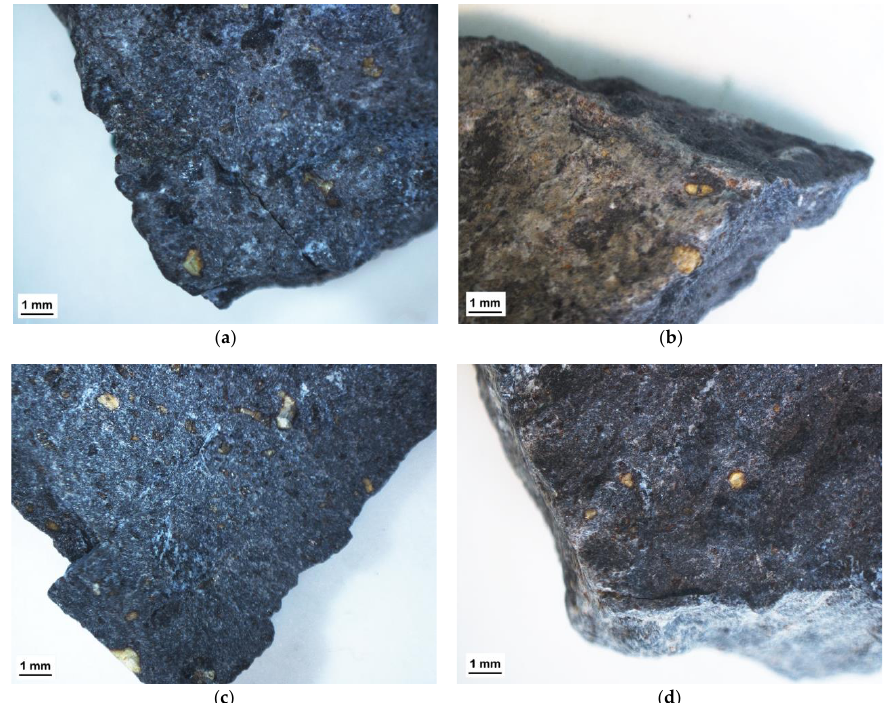
Figure A11. Characteristics of cracks in samples after crushing in cone crusher (feed—non-flaky grains): ( a ) Basalt aggregate 1, non-flaky grains, +8 mm; ( b ) Basalt aggregate 1, non-flaky grains, +16 mm; ( c ) Basalt aggregate 1, flaky grains, +8 mm; ( d ) Basalt aggregate 1, flaky grains, +16 mm.